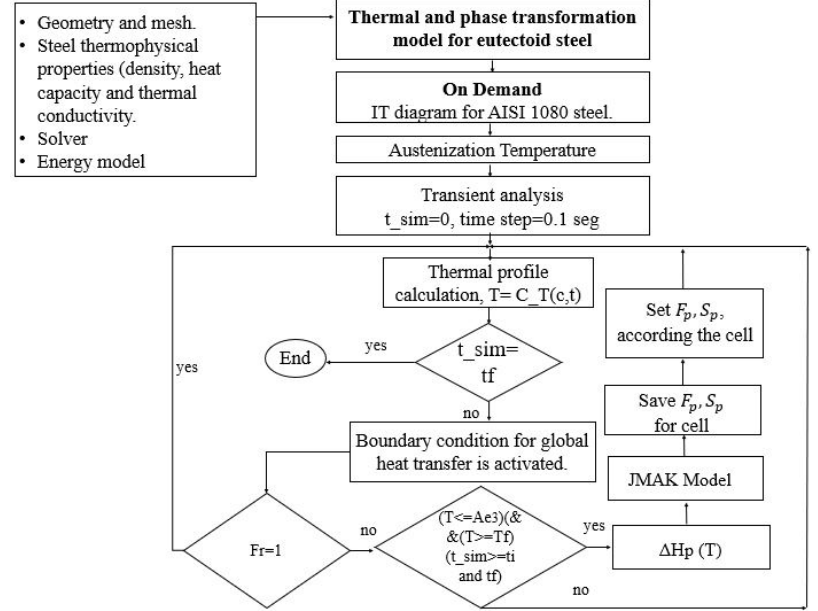
Figure 2. Solution algorithm for the simulation model coupled to the UDF to calculate the microstructural evolution of pearlite using the experimental thermal boundary condition.